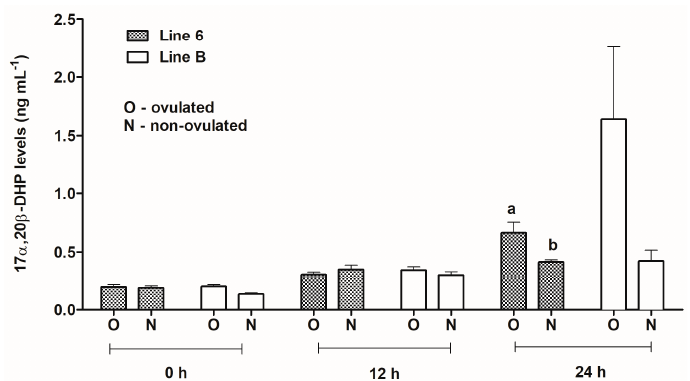
Figure 5. Plasma 17 α ,20 β -DHP levels in blood samples taken from ovulated and non-ovulated females from Polish line 6 and Lithuanian line B before the first injection of Ovopel (0 h) and 12 and 24 h post-injection (12 and 24 h). Different letters indicate significant differences between the levels of steroid concentrations in ovulated and non-ovulated fish within line 6 at 24 h sampling time ( p ≤ 0.05).